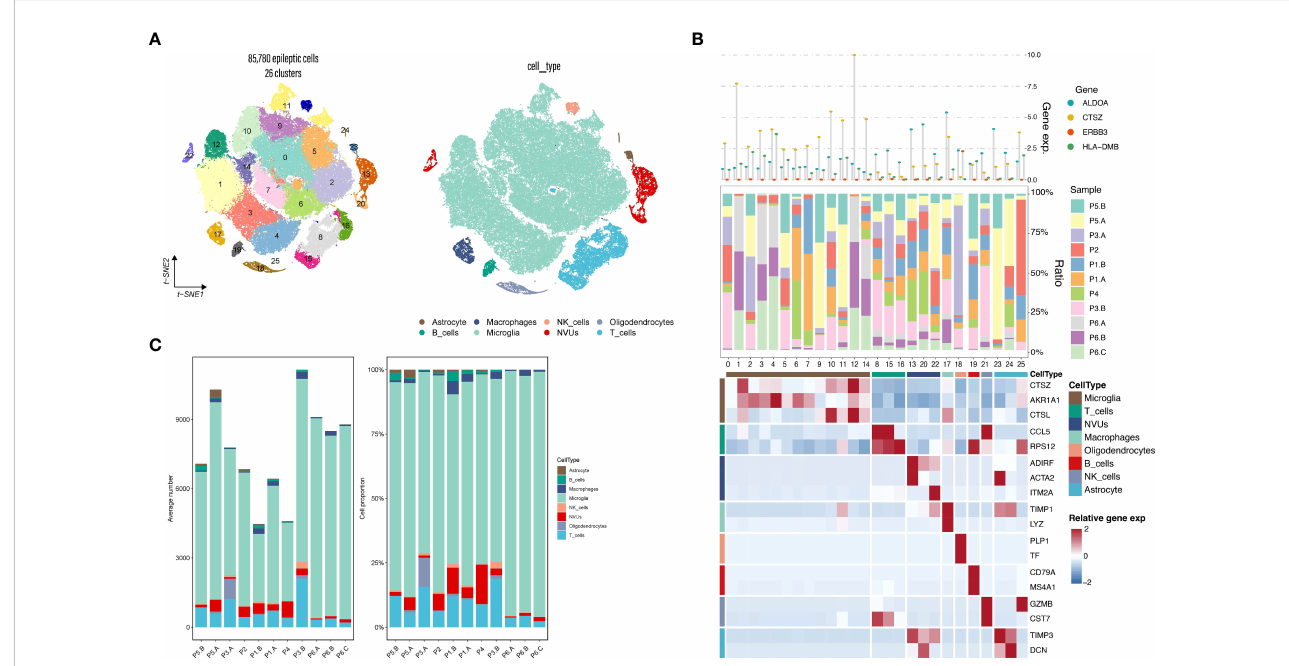
FIGURE 7 Epilepsy single-cell analysis. (A) Single-cell subpopulation clustering and cell annotation. (B) Three-layered complex heatmap of selected co-expressed genes in each cell cluster. Top: Mean expression of co-expressed markers. Middle: Tissue preference of each cluster; Bottom: Relative expression map of known marker genes associated with each cell subset. Mean expression values are scaled by mean-centering, and transformed to a scale from -2 to 2. (C) Average cell number and relative proportion of subsets from tissues of each origin.